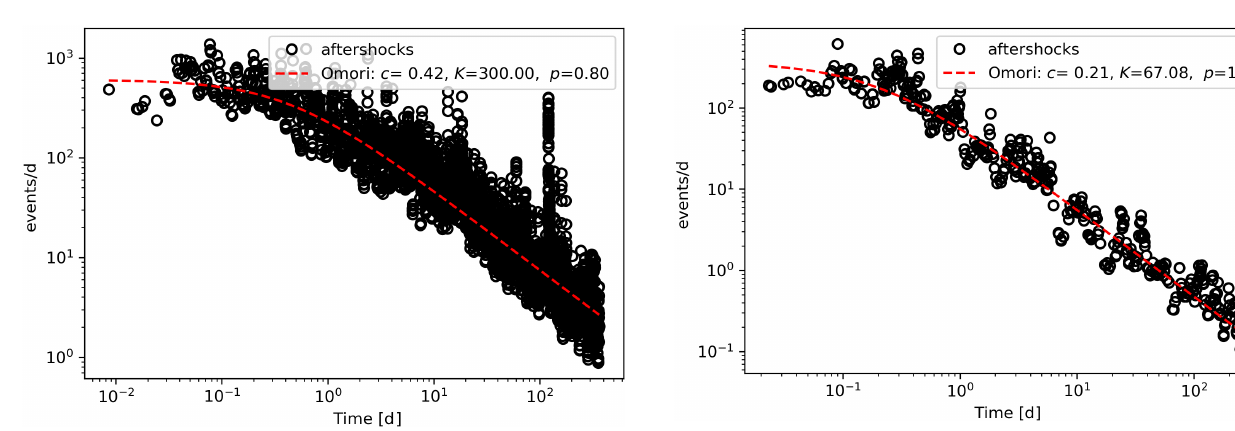
Figure 13. The modified Omori formula aftershock attenuation curve of the Tohoku earthquake.